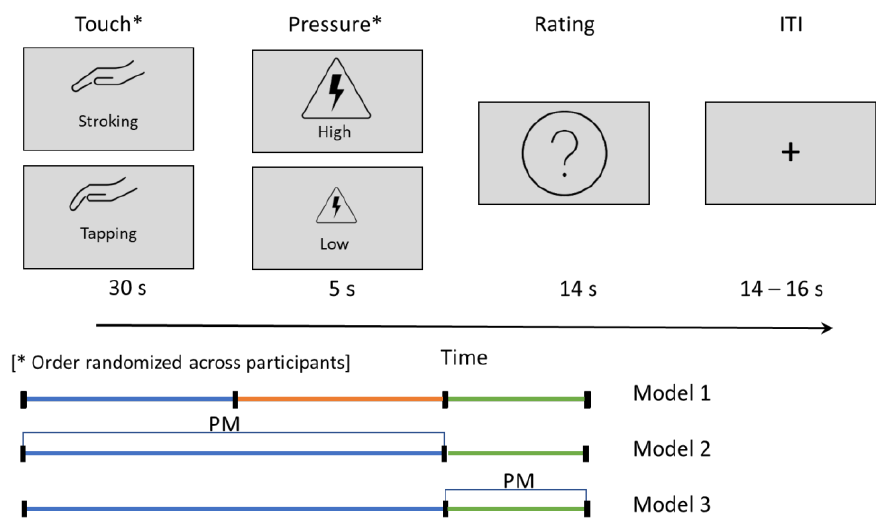
Figure 1. Touch–pain interaction task. Touch types were randomized across four blocks. High- and low-pressure stimuli were randomized within each block. Intertrial interval (ITI) was jittered. The trial phases modeled in the three fMRI first level models are indicated in the bottom. PM = parametric modulator.